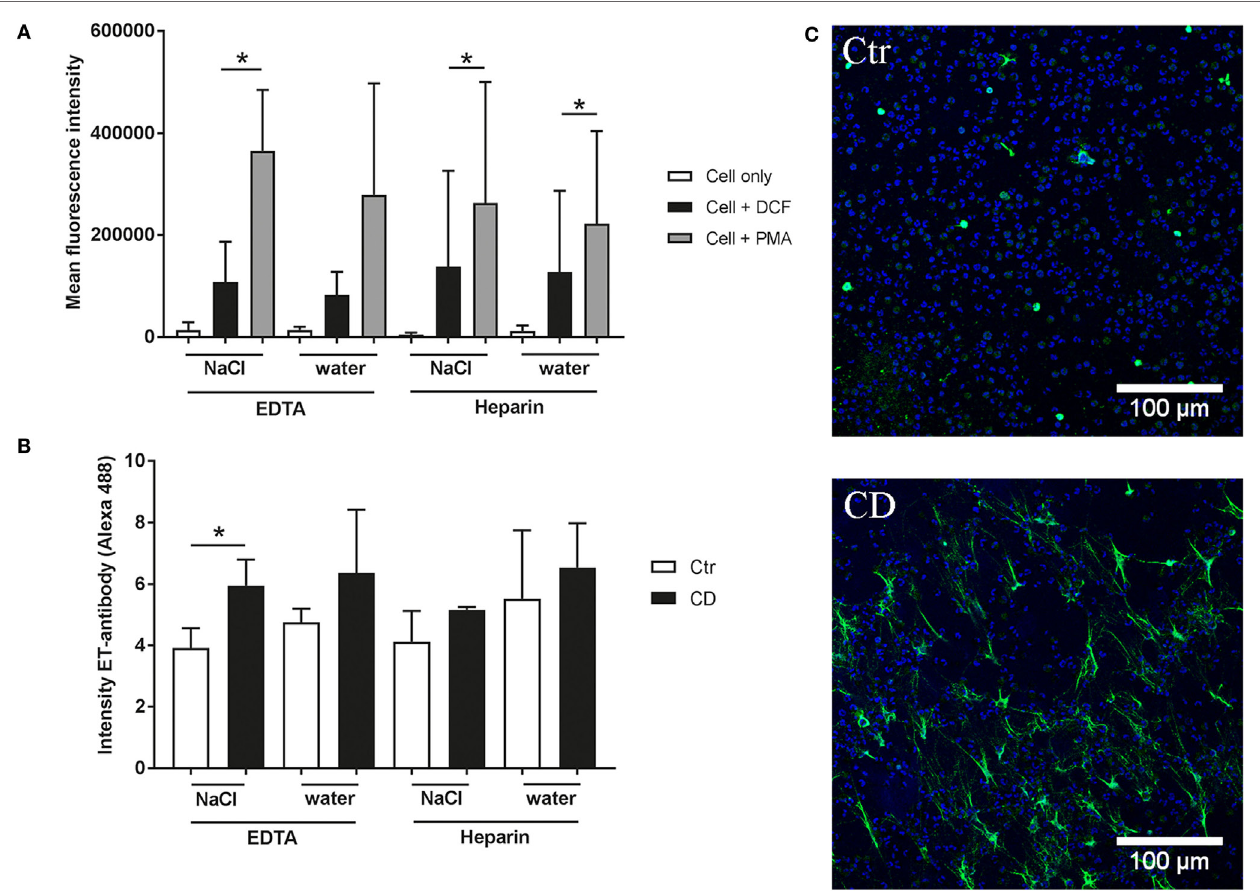
FIGUrE 5 | Reactive oxygen species (ROS) production and extracellular trap (ET) formation of isolated granulocytes. (A) Mean fluorescence intensity (X-mean) of oxidative burst (ROS production) was measured by flow cytometry (BL-1) using DCF fluorescence probe ( n = 3). Phorbol-myristate-acetate (PMA) was used as an inducer for ROS production. A significant difference between control (cell + DCF) and PMA-treated cells was detected in 3 of 4 granulocyte isolation methods. (B,c) Formation of ETs was quantified based on immunofluorescence microscopy. After 2 h incubation at 37°C and 5% CO 2 the cells were fixed. Afterward ET staining for immunofluorescence microscopy was conducted [blue = DNA (Hoechst), green = DNA/histone-1-complexes (NETs)]. Representative pictures are shown from K 3 EDTA/NaCl isolated granulocytes. The isotype control showed no ET-specific signal. Statistical analysis of ET-induction assays was conducted from three independent experiments. Negative control (Ctr) is an unstimulated control (RPMI), methyl- β -cyclodextrine (CD) was used as positive NET inducer. Per sample, 6 pictures were taken on 2 slides at predefined positions, and the fluorescence intensity of NET-positive cells was determined using ImageJ software. A significant difference between negative and positive samples was detected in K 3 EDTA/NaCl isolated granulocytes. Statistical significance was tested with one-tailed, paired Student’s t -test, P value * P < 0.05 was considered